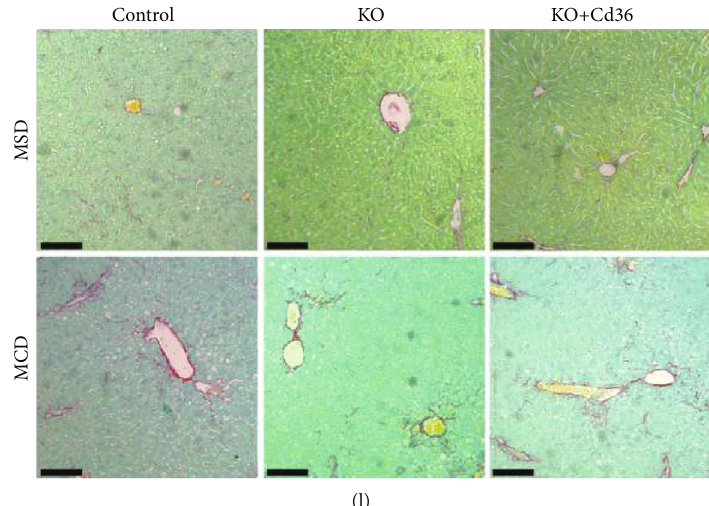
Figure 4: Pparg Δ Hep reduced MCD-induced fi brogenesis. Plasma (a) ALT and (b) AST levels. Hepatic expression of (c) tumor necrosis factor alpha ( Tnfa ), (d) F4/80 , (e) transforming growth factor beta 1 ( Tgfb1 ), (f) alpha smooth muscle actin ( aSma ), (g) collagen 1a1 ( Col1a1 ), (h), metalloproteinase 13 ( Mmp13 ), and (i) TIMP metallopeptidase inhibitor 1 ( Timp1 ). (j) Quanti fi cation of picrosirius red area represented as percentage of red-stained area. (k) 20x representative images of hematoxylin and eosin-stained liver sections. (l) 10x representative images of picrosirius red/fast green-stained liver sections. Values are represented as the mean ± standard error of the mean . Hepatic gene expression is represented as an absolute mRNA copy number normalized by a normalization factor (NF). Letters represent signi fi cant di ff erences between MSD and MCD within groups. Asterisks indicate signi fi cant di ff erences between groups within the same diet. ∗ , A p < 0 : 05 ; ∗∗ , B p < 0 : 01 ; ∗∗∗ , C p < 0 : 001 . Control mice (C); Pparg Δ Hep mice (KO); Pparg Δ Hep mice with hepatocyte Cd36 overexpression (KO+Cd36). MSD diet: open columns, open symbols; MCD diet: close columns, close symbols. n = 3 ‐ 7 mice/group. Bar = 50 μ M (k); 100 μ M